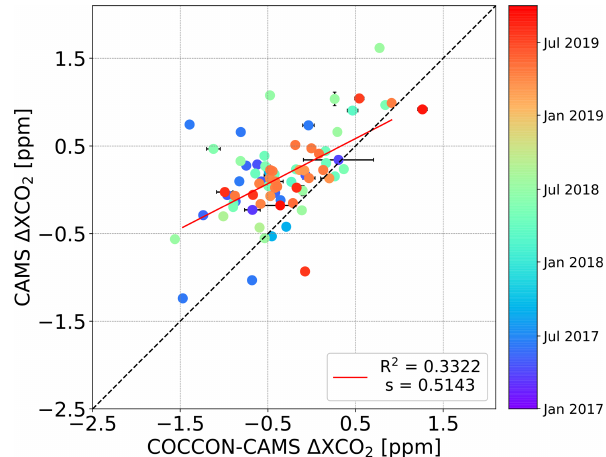
Figure 11. Difference in XCO 2 measured between Kiruna and So- dankylä. This plot is showing the comparison between CAMS and COCCON-CAMS. The annotations follow those in Fig.